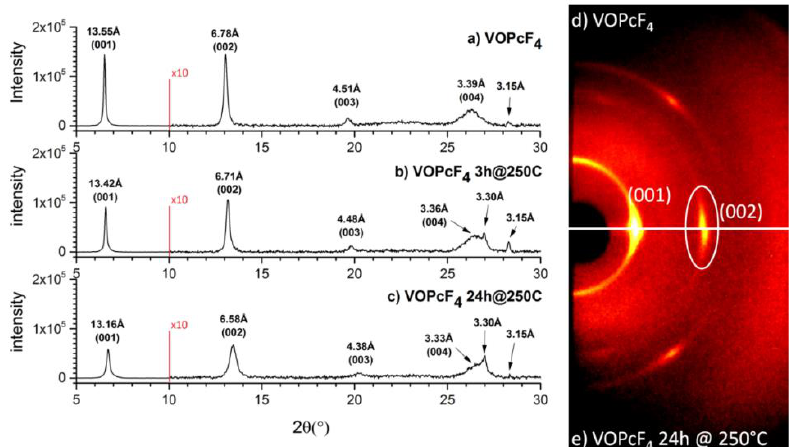
Figure 3. XRD patterns of a VOPcF 4 film: as-deposited ( a ), after annealing for 3 hours at 250 °C ( b ) and for 24 hours at 250 °C ( с ). The range from 10° to 30° 2θ is shown with 10-fold magnification. 24 h at 250 ◦ C ( c ). The range from 10 ◦ to 30 ◦ 2 θ is shown with 10-fold magnification. 2D GIXD patterns 2D GIXD patterns before ( d ) and after annealing ( e ). before ( d ) and after annealing ( e